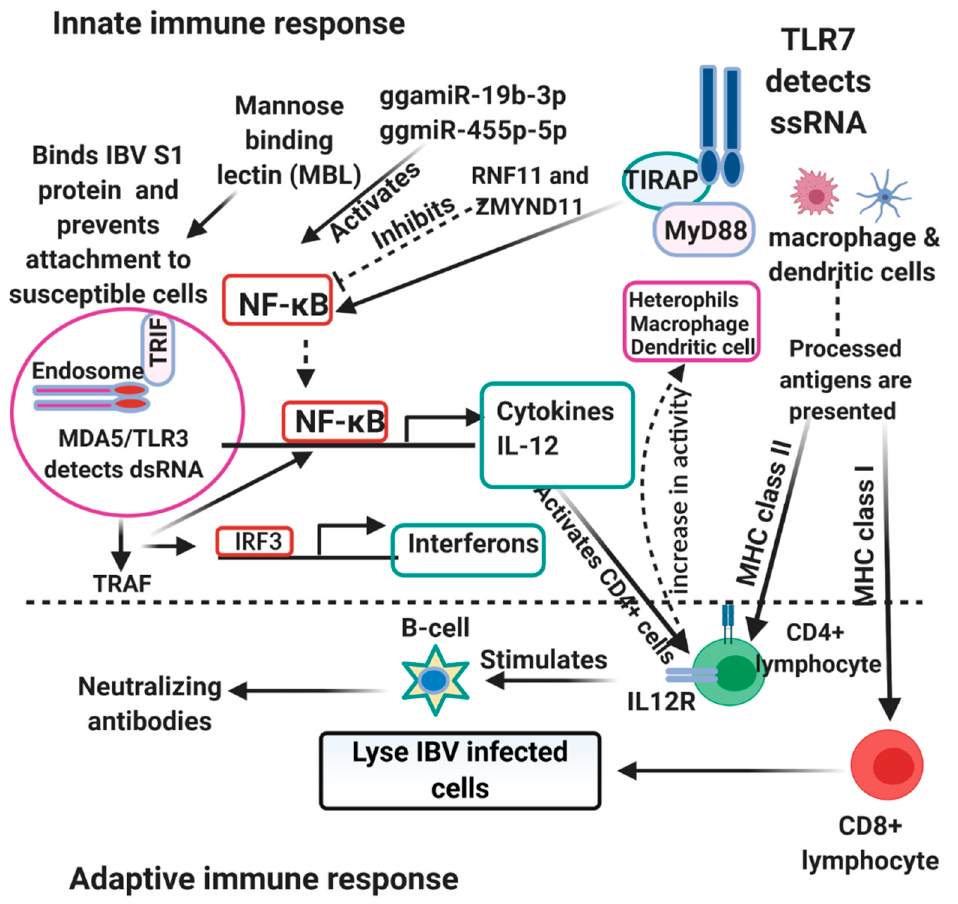
Figure 1. Host immune response to Infectious bronchitis virus (IBV) and Newcastle disease virus (NDV). The Toll-like receptors 4, 15, and 16 on macrophages, dendritic cell and heterophils sense and activate the NF- κ B which leads to production of cytokines. Peptides from the virus is also processed and presented to the adaptive immune cells (CD4+/CD8+) by the antigen-presenting cells (APCs) in the company of the major histocompatibility complex II/I (MHCII/MHCI). The adaptive immune cells stimulate the production of neutralizing antibodies and stimulate interferon production which also increases the phagocytic ability of macrophages, dendritic cells and heterophils. NDV inhibits NF- κ B by RNF11 and ZMYND11, while the miRNA ggmiR-19b-3p activates NF- κ